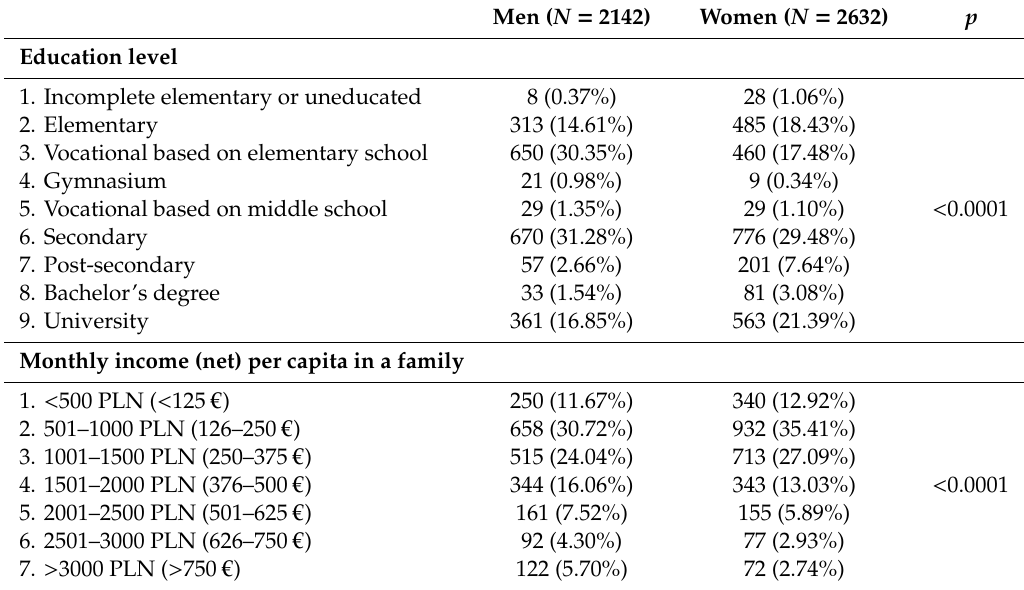
Table 1. Distribution of education level and monthly income (net) per capita in a family, according to gender.